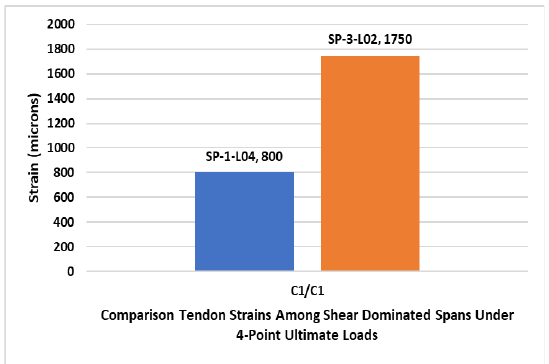
Figure 48. Comparison of maximum tendon strains recorded under four-point ultimate loads between specimen SP-1 and SP-3.